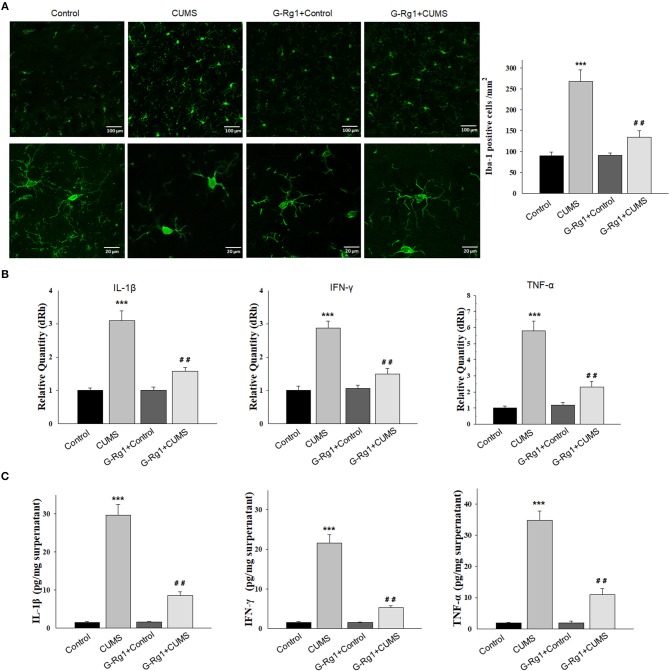
Ginsenoside-Rg1 attenuated microglial activation and inflammatory cytokine expressions induced by CUMS-exposure. (A) CUMS exposure significantly increased the number of Iba1 positive microglial cells within the vmPFC. Microglial cells retracted their processes and assumed a rounded morphology indicative of activated microglia. All of these CUMS-induced effects were significantly attenuated by ginsenoside-Rg1 pretreatment. (B) Real-time quantitative PCR assays showed that CUMS exposure increased IL-1β, IFN-γ, and TNF-α mRNA expression within the vmPFC, effects which were suppressed by ginsenoside-Rg1. (C) ELISA assays showed that CUMS exposure increased IL-1β, IFN-γ, and TNF-α protein expressions within the vmPFC, effects which were ameliorated by ginsenoside-Rg1. Data were presented as the means ± SEM (N = 6). ***P < 0.001 CUMS vs. Control group; ##P < 0.01 G-Rg1+CUMS vs. CUMS group. G-Rg1, Ginsenoside-Rg1.